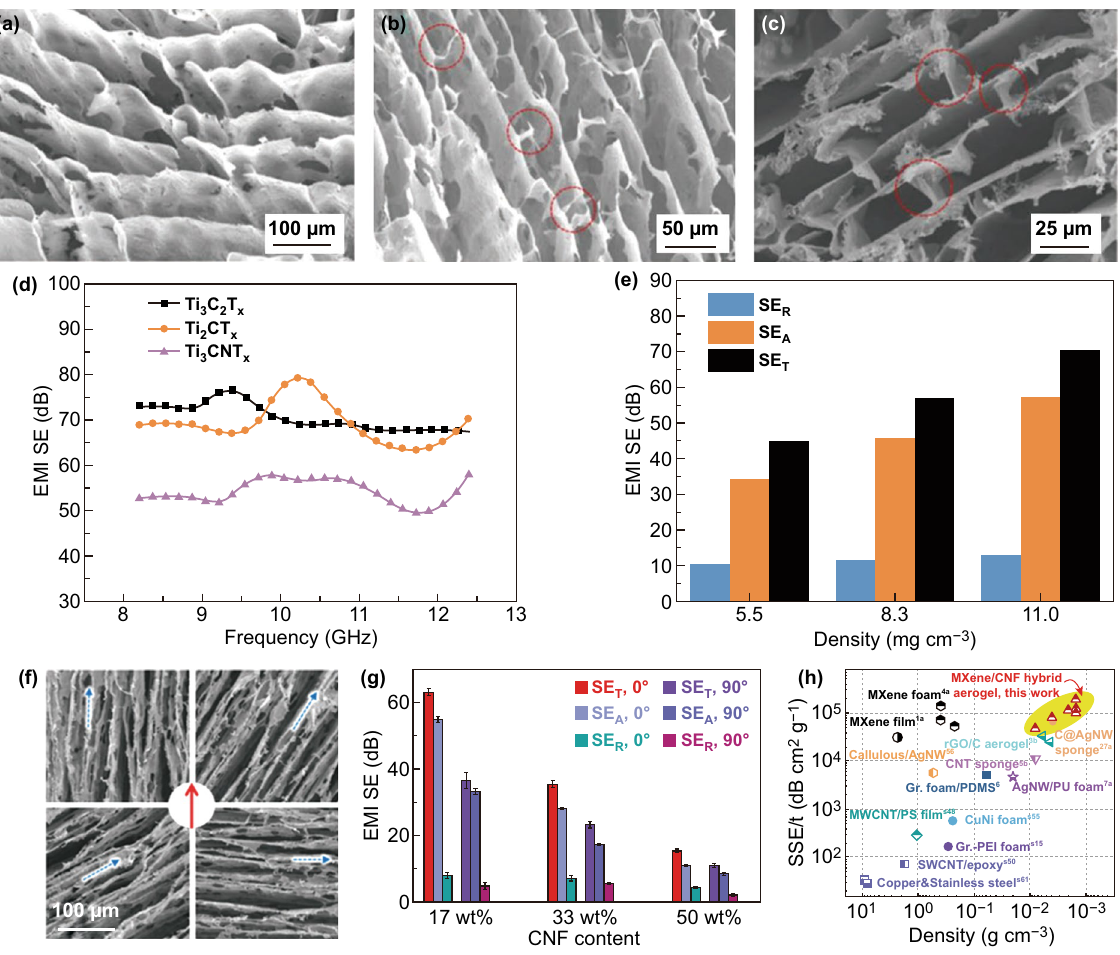
Fig. 7 SEM images of Ti 3 C 2 T x aerogels with the densities of a 5.5, b 8.3, and c 11.0 mg cm −3 , respectively. Interlayer synapses and bridges are circled in red. d Frequency‑dependent EMI SE of different MXene aerogels at a density of 11.0 mg cm −3 and a compression thickness of 1 mm. e The average EMI SE of Ti 3 C 2 T x aerogels with different densities. Reproduced with permission from Ref. [104]. Copyright 2019, WILEY– VCH. f SEM images of the MXene/CNF hybrid aerogels with various angles between the cell walls’ oriented direction and electric field direc‑ tion of incident EM waves. g EMI shielding performance at a fixed frequency of 10 GHz for the MXene/CNF hybrid aerogels (4 mg cm −3 ) with various CNF contents at cell wall‑electric field angles of 0° and 90°, respectively. h Comparison of the MXene/CNF hybrid aerogels’ shielding performance with other materials. Reproduced with permission from Ref. [106]. Copyright 2020,